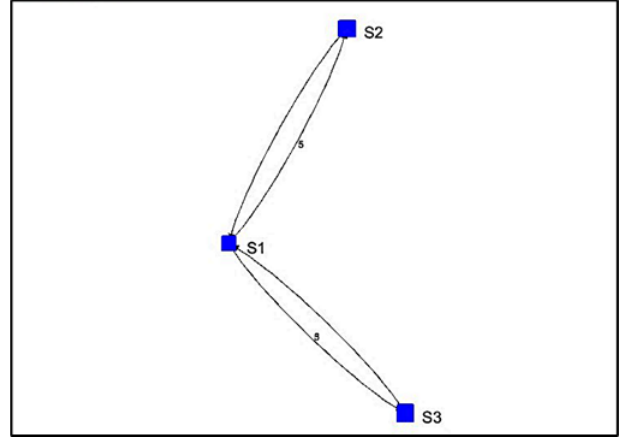
Figure 13. Algorithm 2 ’ s visualization of Path 2 vectors.